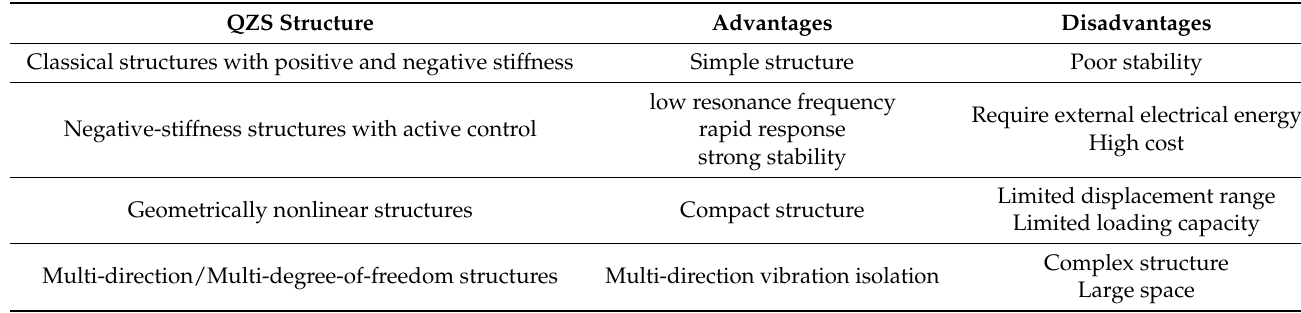
Table 2. Comparisons of four QZS implementation structures.